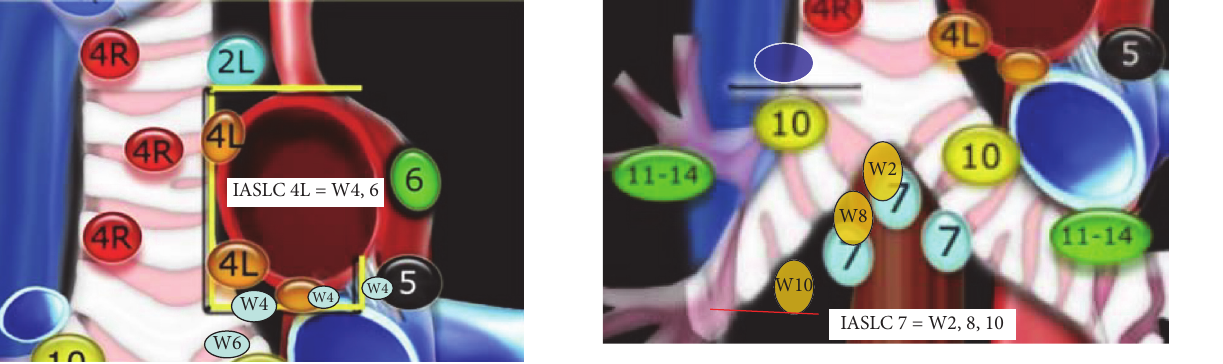
Figure 1: Correlation between IASLC and Wang LN MAP; IASLC 4L: left lower paratracheal LN; W4: A-P window; W6: left main bronchus LN.